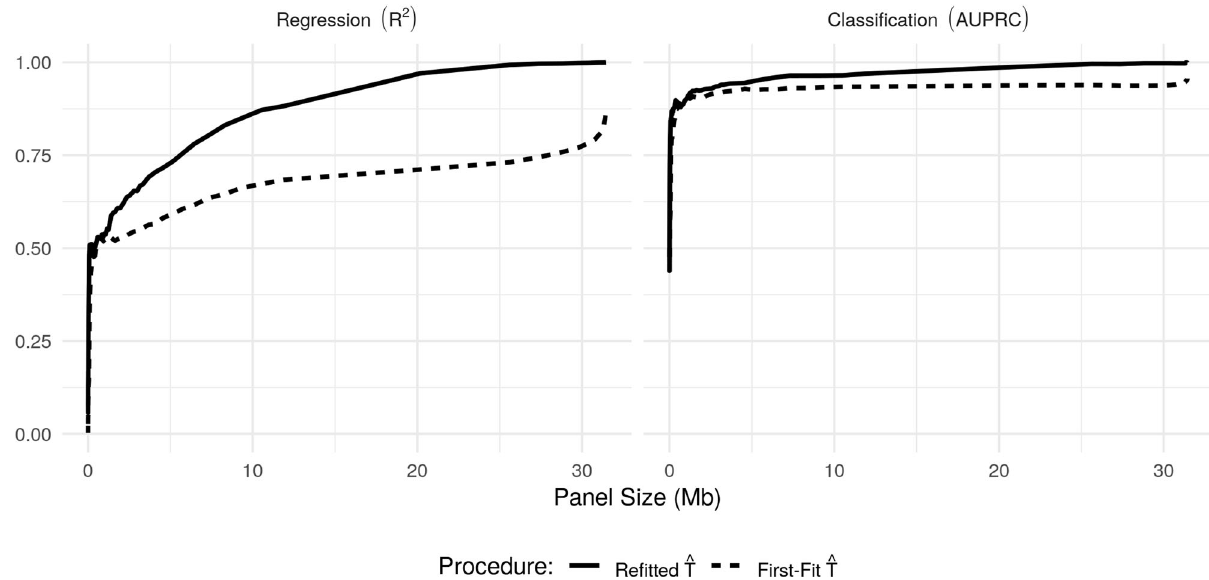
Fig. 5 Estimating TIB on the validation dataset. Performance of our fi rst- fi t and re fi tted estimators of TIB as the selected panel size varies. Left: R 2 , Right: